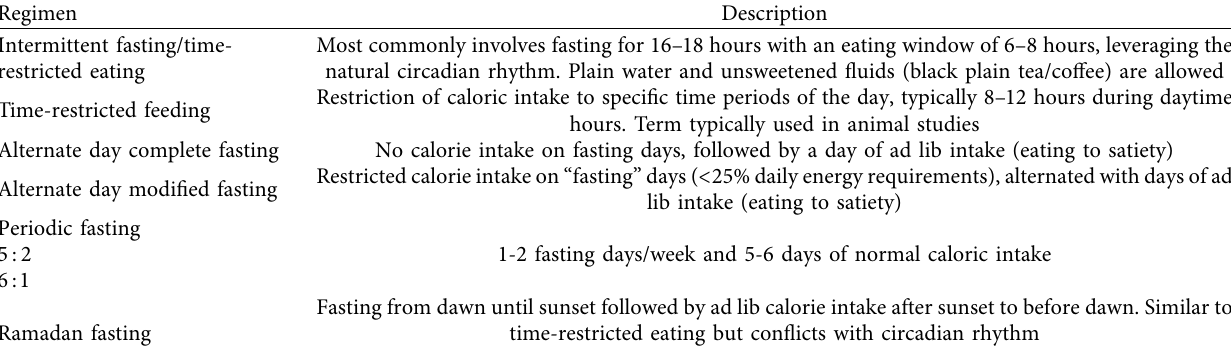
Table 1: Summary of typical intermittent fasting/time-restricted eating regimens.